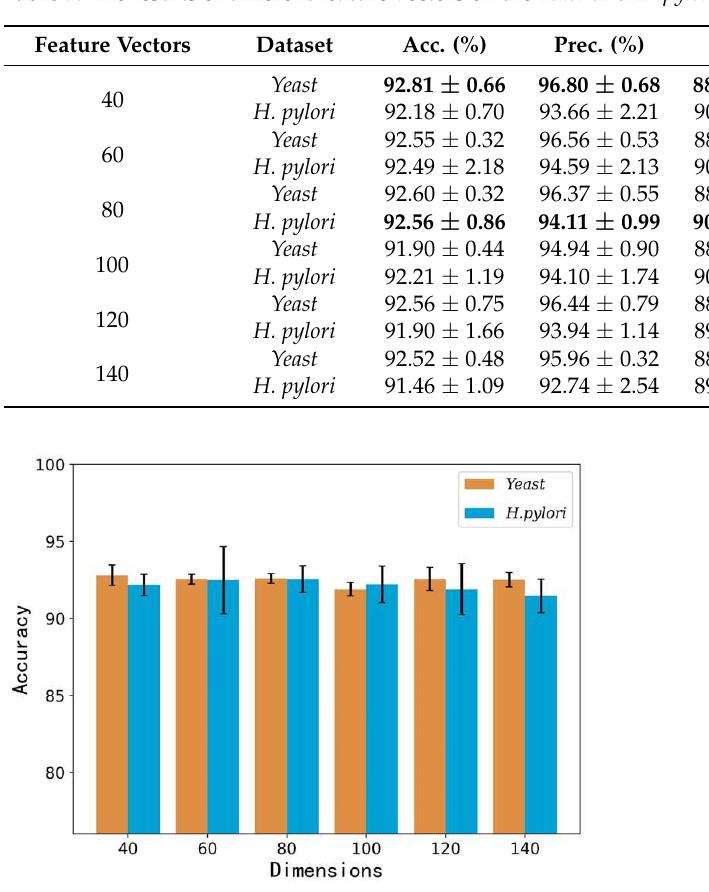
Figure 1. The accuracy performance of the Yeast and H. pylori datasets. In the rotation forest algorithm, there are two main parameters in the rotation forest classifier: K and L . where K represents the number of feature subsets, L denotes the num- ber of decision trees. We select the best parameter after the experiment and set K, L as 5, 5, respectively. The results of the two datasets were shown in Tables 2 and 3. Table 2. Prediction performance of the Yeast dataset based on five-fold cross-validation method. Testing